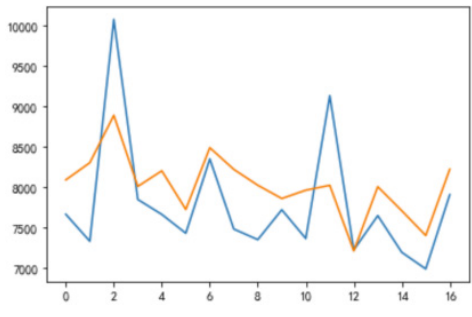
Figure 7. A330 fuel consumption forecast.